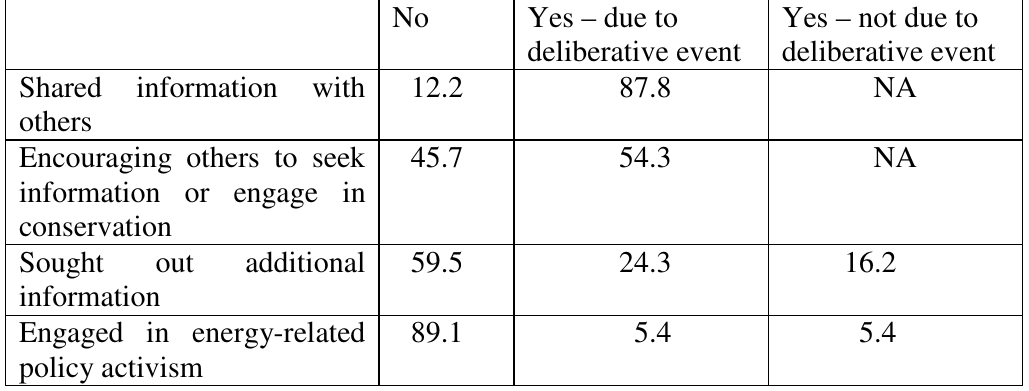
No Yes – due to Yes – not due to deliberative event deliberative event 12.2 87.8